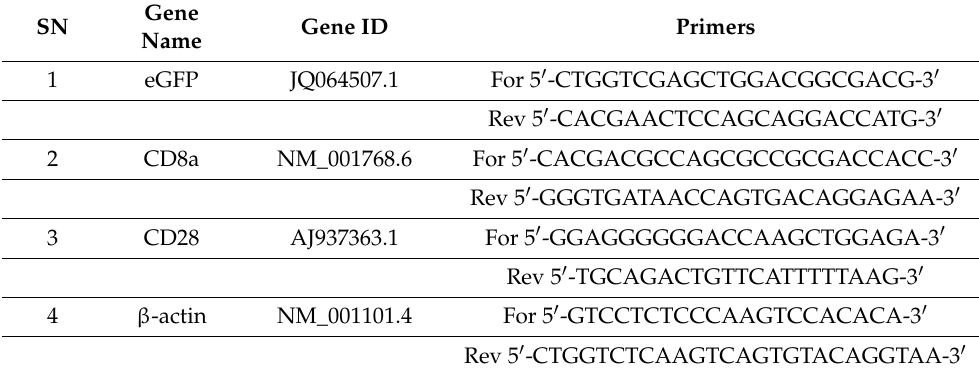
Table 1. List of human primers for semi-quantitative